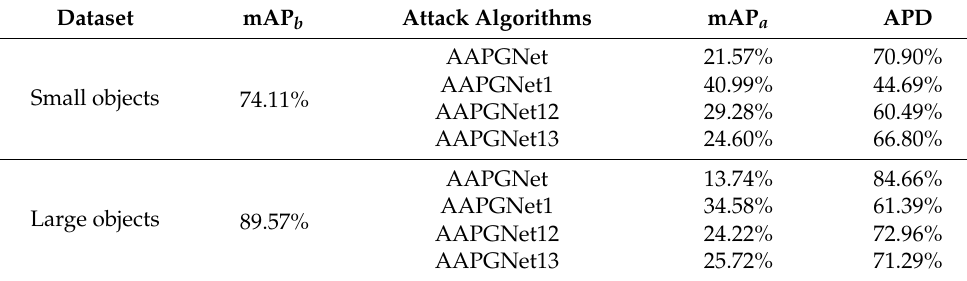
Table 1. Testing result of the scale adaptiveness.